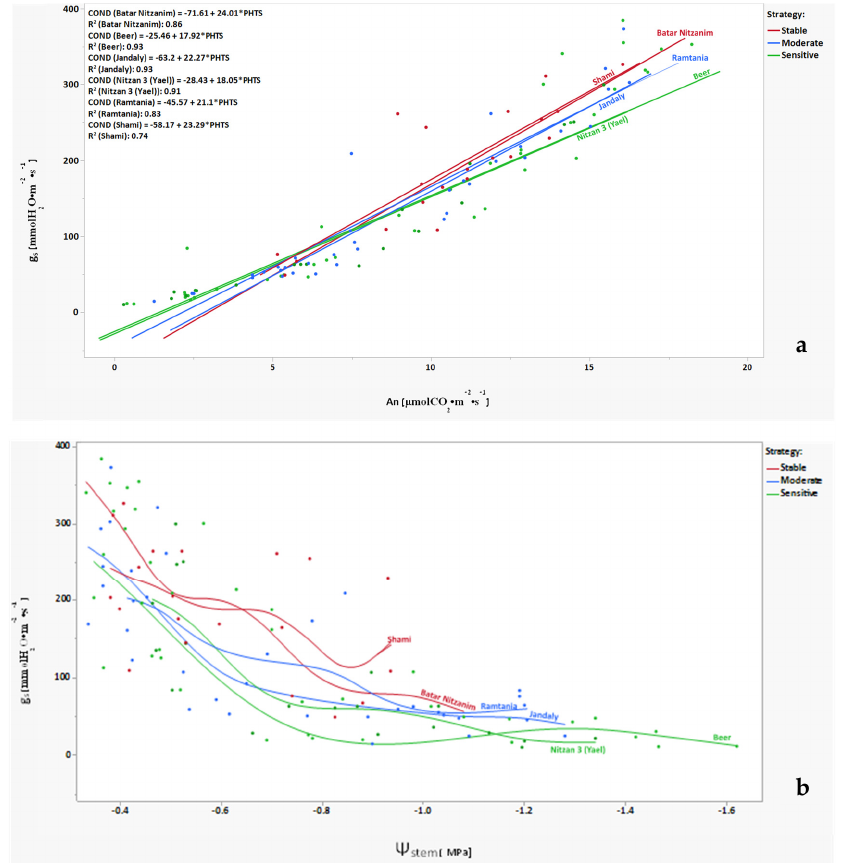
Figure 2. Correlations between physiological parameters during drought stress experiment. ( a ) Correlation between stomata conductance (g s ) and photosynthesis (An). Two varieties represent each response strategy. ( b ) Correlation between stomata conductance (g s ) and stem water potential ( Ψ stem ). Two varieties represent each response strategy. Each dot represents data for a specific vine at a specific time point during the drought experiment, four vines per variety.